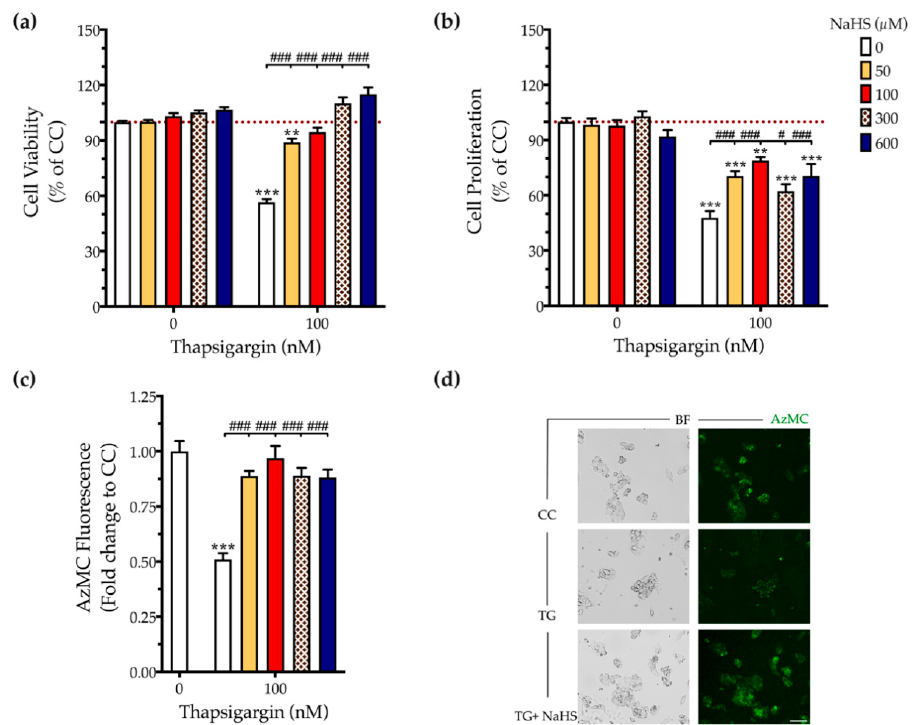
Figure 2. NaHS co-treatment normalizes the endogenous H 2 S levels and rescues hepatic-cell viability and proliferation during chronic ER stress. HepG2 cells were serum-starved for 8 h and treated with the vehicle or 100 nM of thapsigargin (TG), in the presence or absence of NaHS for 16 h. Micro-cultures were assayed for the XTT conversion ( a ) and BrdU incorporation ( b ) to assess cell viability and proliferation, respectively. Alternatively, micro-cultures were labeled with 100 µ M AzMC to quantify the endogenous H 2 S levels ( c ). Representative pictures of the AzMC signal were captured with an Olympus CKX53 inverted microscope at 10 × magnification; the left sub-panel corresponds to the bright-field channel (BF) for whole-cell imaging, whereas the right sub-panel to the DAPI fluorescent channel for AzMC imaging ( d ). Each bar represents mean ± SEM from four independent experiments. Data are expressed as a percentage or fold change of the control (vehicle-treated) conditions (CC). ** p ≤ 0.01; *** p ≤ 0.001, when compared to CC; # p ≤ 0.05; ### p ≤ 0.001, when compared to